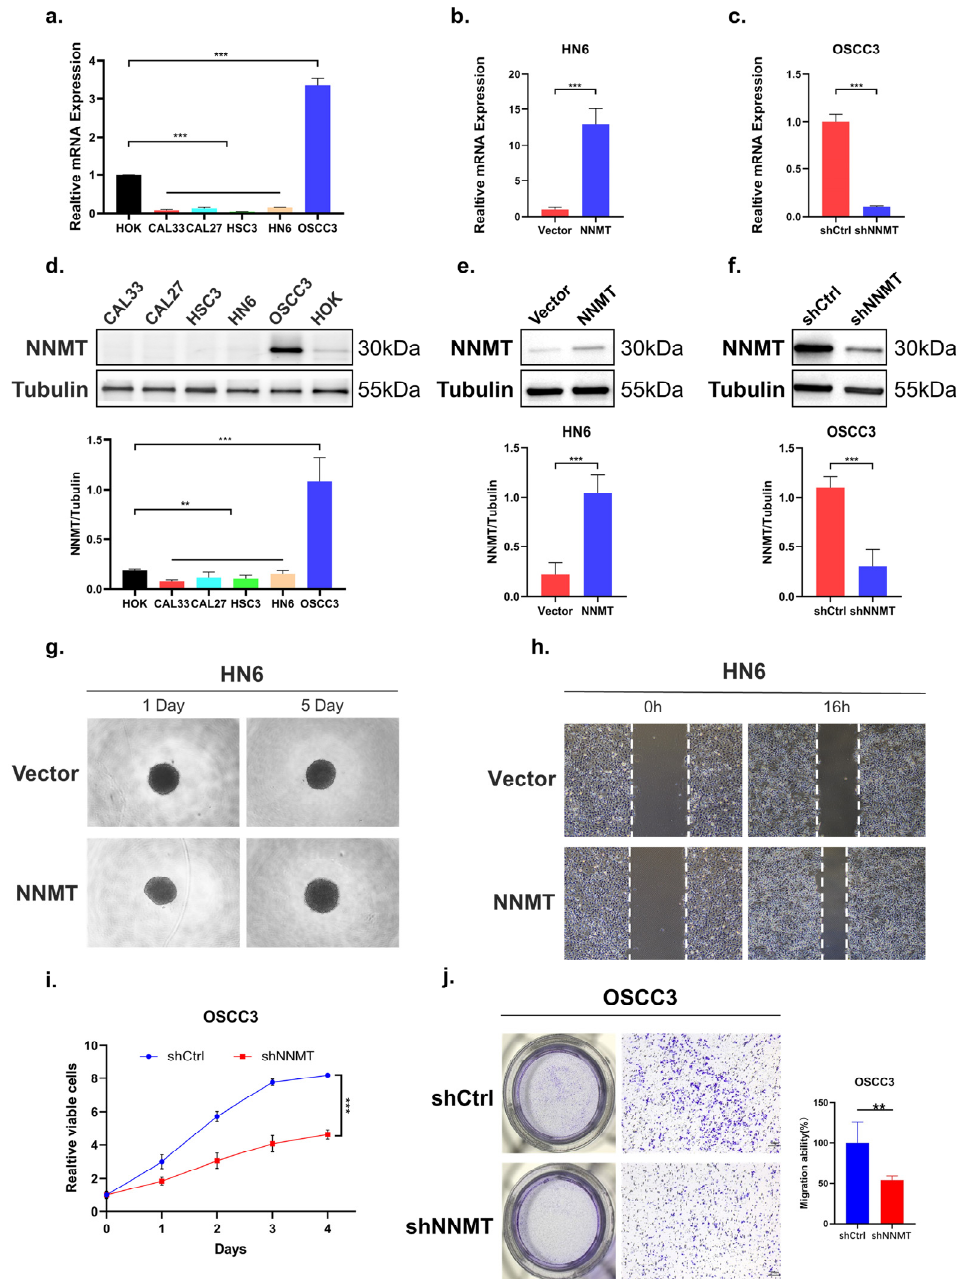
Figure 5. NNMT promoted the cell proliferation and migration of OSCC cells. ( a , d ) NNMT mRNA and protein expression in several OSCC cell lines. ( b , e ) Ectopic expression of NNMT in HN6 cells, confirmed using qPCR and Western blot. ( c , f ) Knockdown expression of NNMT in OSCC3 cells, confirmed using qPCR and Western blot. ( g , h ) Ectopic expression of NNMT significantly promoted proliferation and migration ability. ( i , j ) Knockdown expression of NNMT significantly inhibited proliferation and migration ability. ** and *** represented differences were considered statistically significant with p < 0.01 and p < 0.001, respectively.